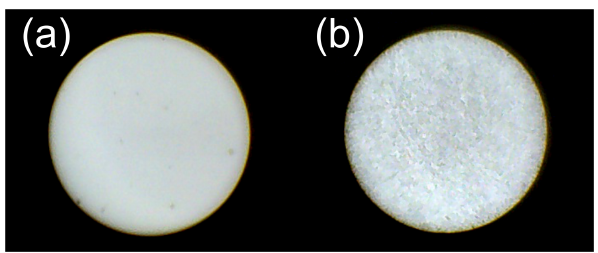
Figure 7. 800µm fibre under the microscope with 30x magnifica- tion. (a) untreated (factory polished) (b) roughened (12µm sheet).